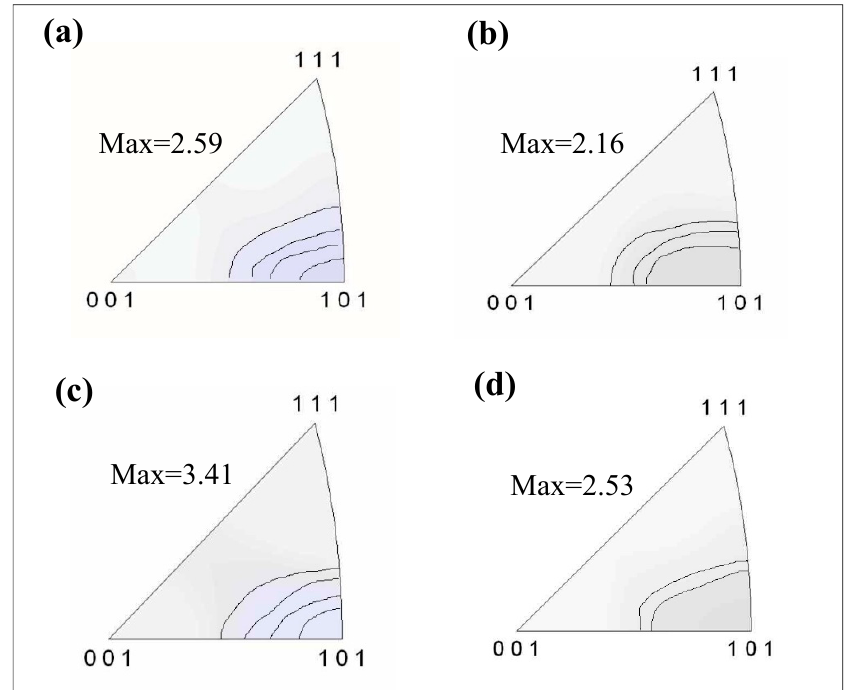
Figure 8. Textures in the Cu-Ni-Co-Si-Cr alloy and Cu-Ni-Co-Si-Cr-Ce alloy represented by inverse pole figures for the compression direction. ( a ) and ( b ) Cu-Ni-Co-Si-Cr alloy deformed at 600 °C, 0.001 s − 1 and 900 °C, 0.001 s − 1 , respectively; ( c ) and ( d ) Cu-Ni-Co-Si-Cr-Ce alloy deformed at 600 °C, 0.001 s − 1 and 900 °C, 0.001 s − 1 , respectively.